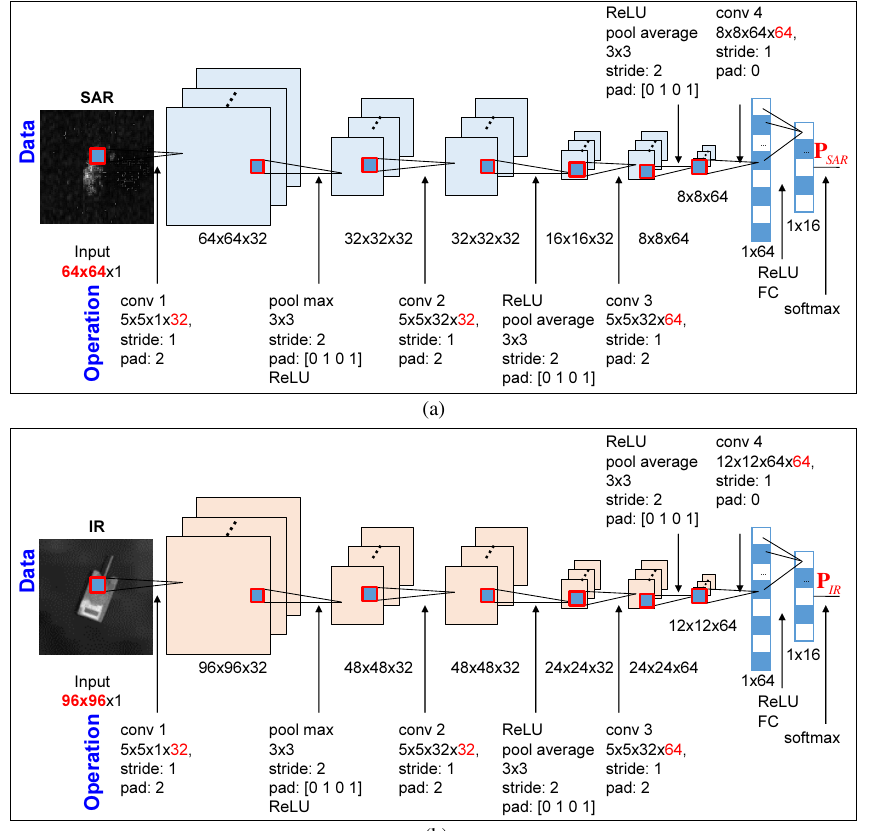
Figure 6. Details of 14-layered deep convolutional network: ( a ) 14 layered SAR-CNN; ( b ) 14 layered